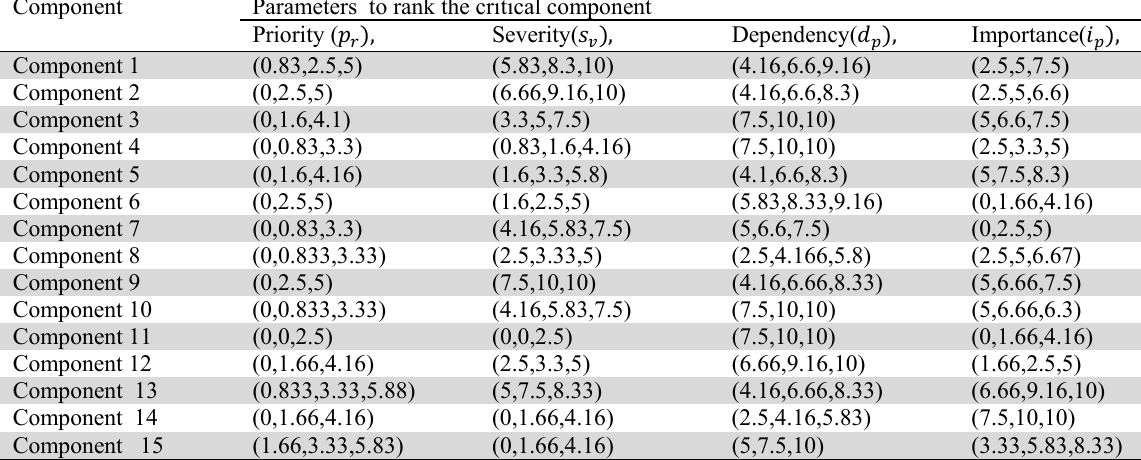
Average rating of decision maker for different code smell in fuzzy number